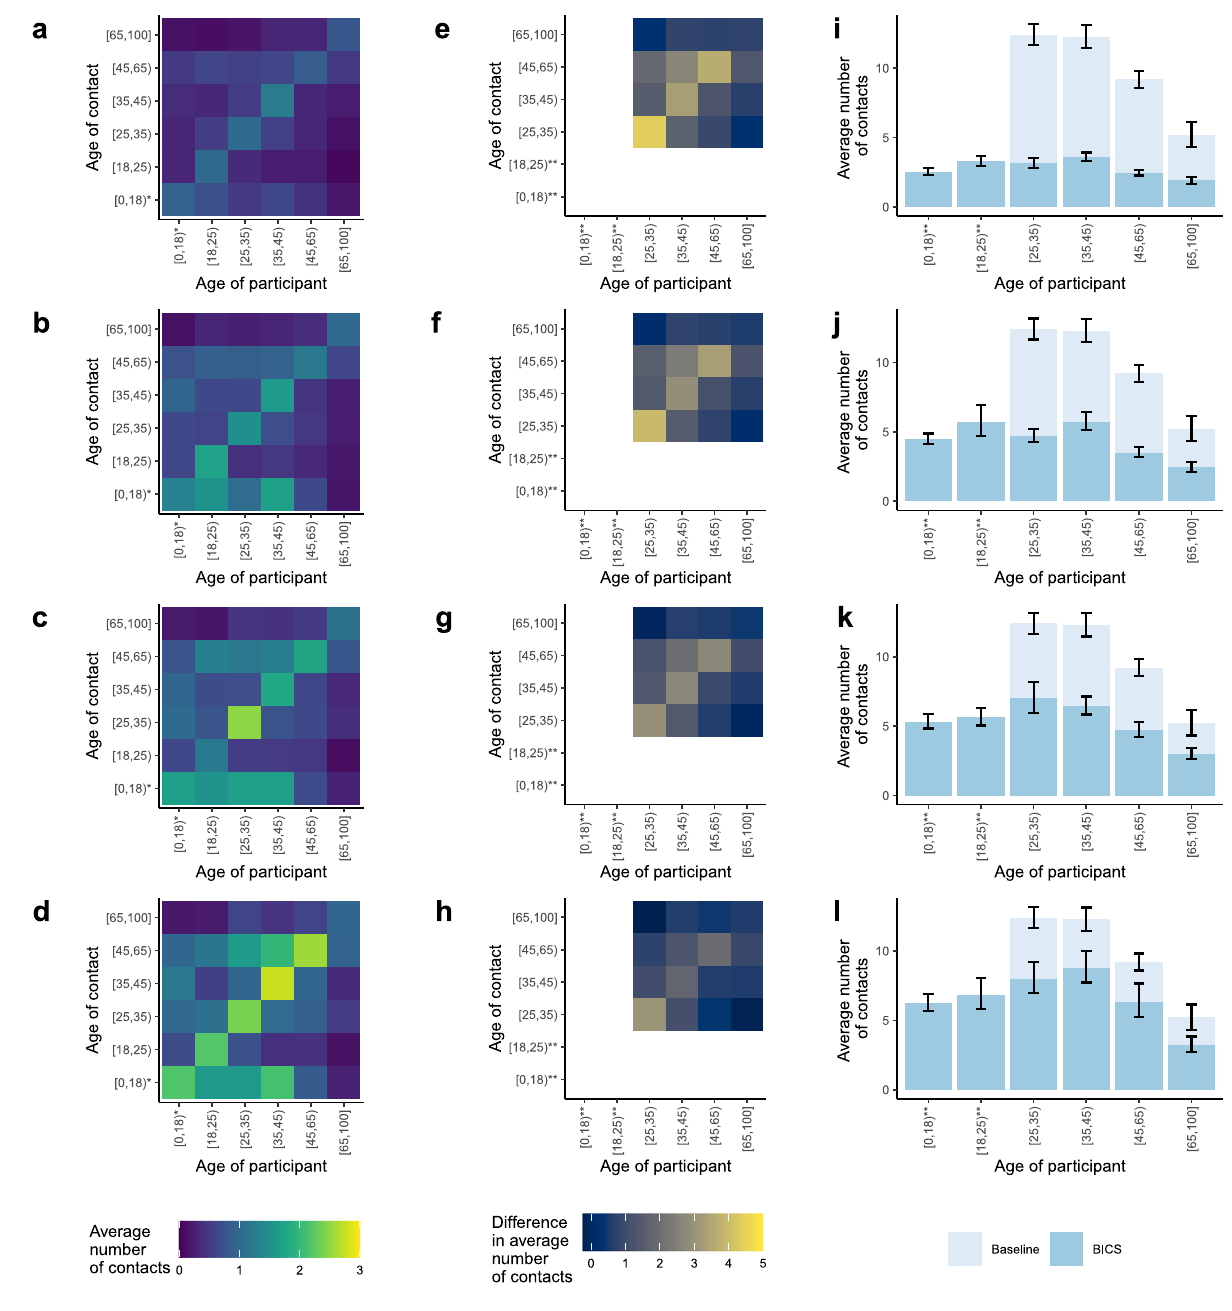
Fig. 3 Comparison of age-structured contact matrices with baseline. a – d Age-structured contact matrices from the four BICS waves after adjusting for the age distribution of survey respondents and the reciprocal nature of contacts; lighter colors indicate higher number of average daily contacts. e – h Difference in the average number of contacts between the 2015 study and the four BICS waves; lighter colors indicate a larger absolute difference between the 2015 study and the BICS data. i – l Average number of reported contacts for each respondent age group for the BICS data (darker color) compared to the 2015 study (lighter color), along with 95% con fi dence intervals derived from the bootstrap. The BICS estimates are based on n = 3163 in Wave 0, n = 7473 in Wave 1, n = 7842 in Wave 2, and n = 11,402 in Wave 3 reported contacts; The 2015 study estimates are based on n = 5944 reported contacts. Top row shows BICS Wave 0; second row shows BICS Wave 1; third row shows BICS Wave 2; and bottom row shows BICS Wave